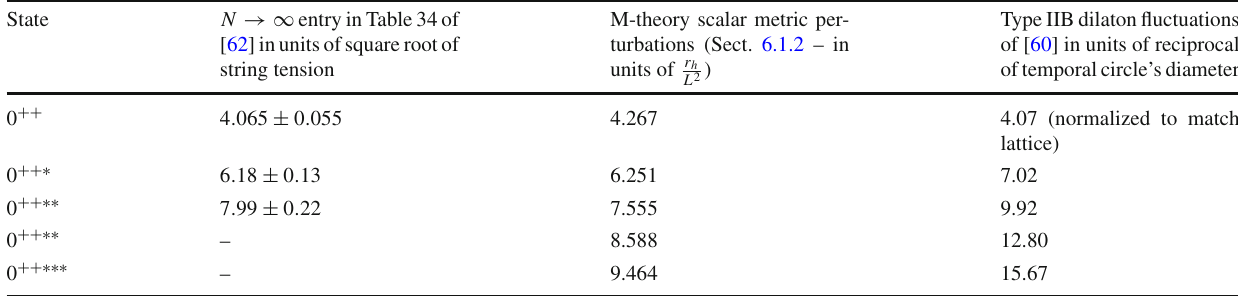
M-theory scalar metric per- Type IIB dilaton fluctuations turbations (Sect. 6.1.2 – in of [60] in units of reciprocal units of r h ) L 2